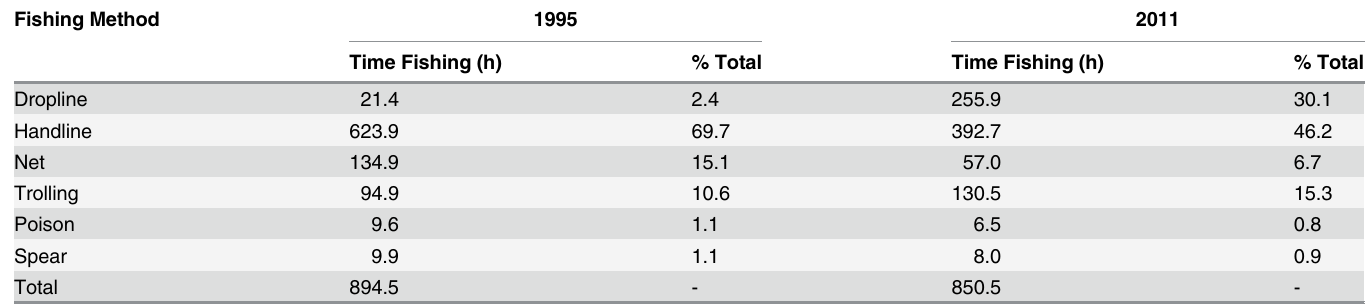
Table 1. Time spent fishing using various methods in 1995 and 2011 within the Roviana lagoon study area. Fishing